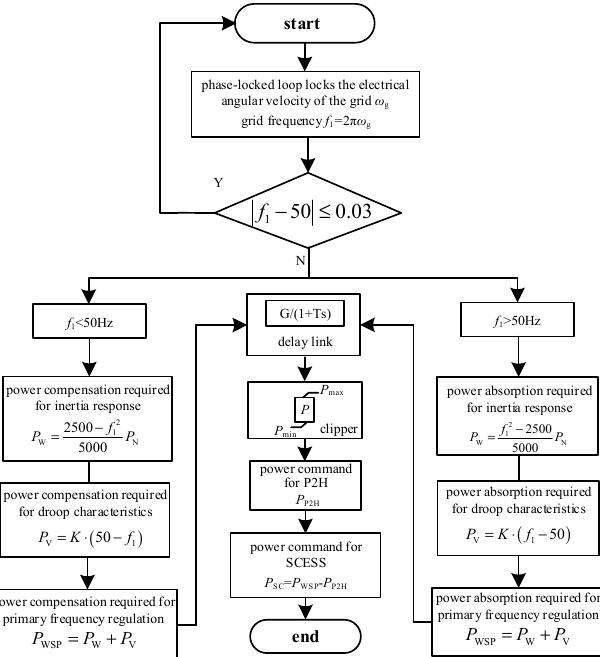
Figure 10. Control flow chart of wind storage hydrogen power station.